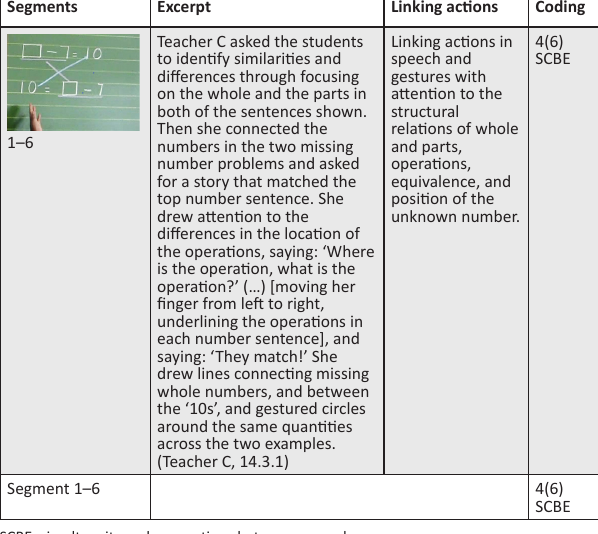
FIGURE 3: Teaching missing number problems, SCBE